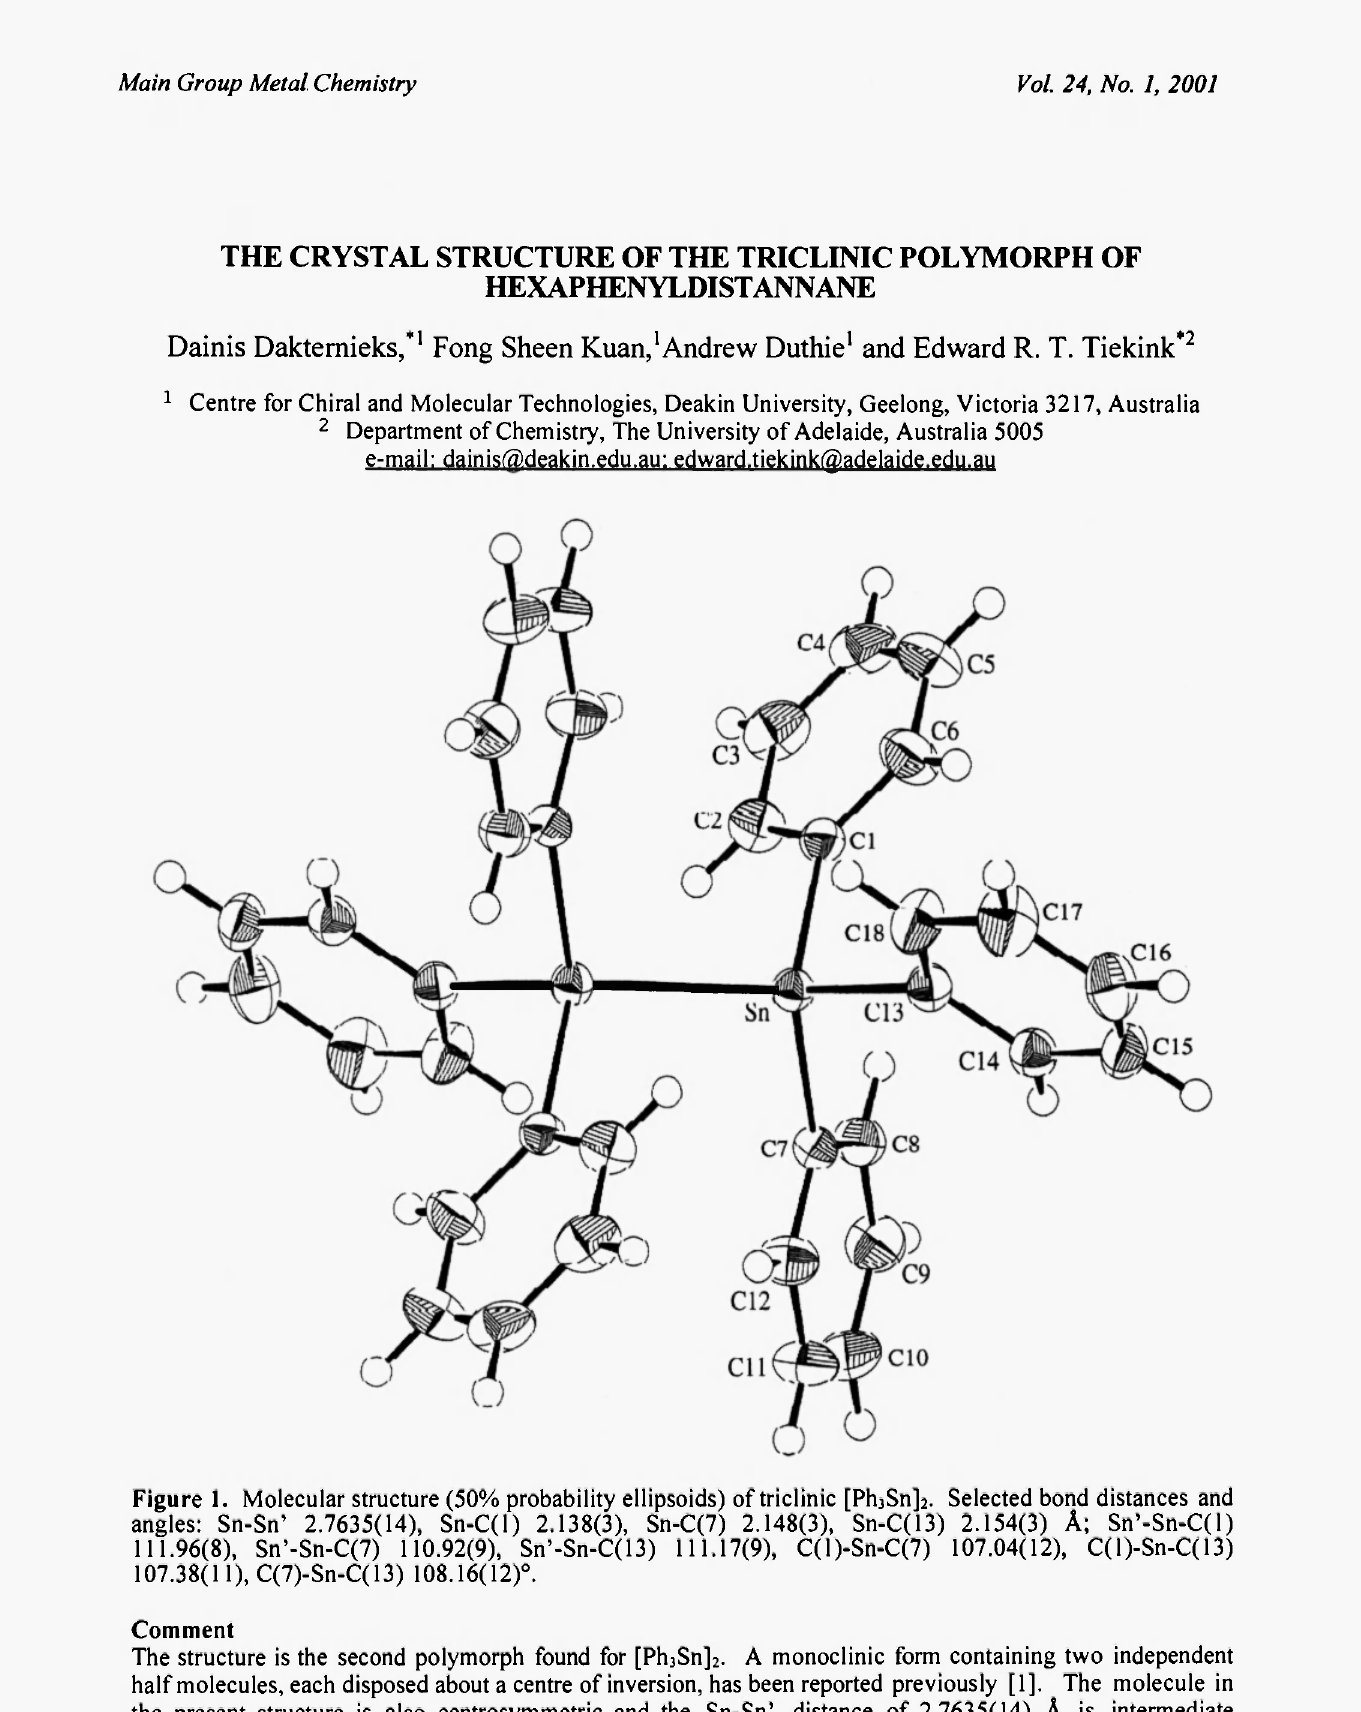
Figure 1. Molecular structure (50% probability ellipsoids) of triclinic [Ph 3 Sn] 2 . Selected bond distances and angles: Sn-Sn' 2.7635(14), Sn-C(l) 2.138(3), Sn-C(7) 2.148(3), Sn-C(13) 2.154(3)